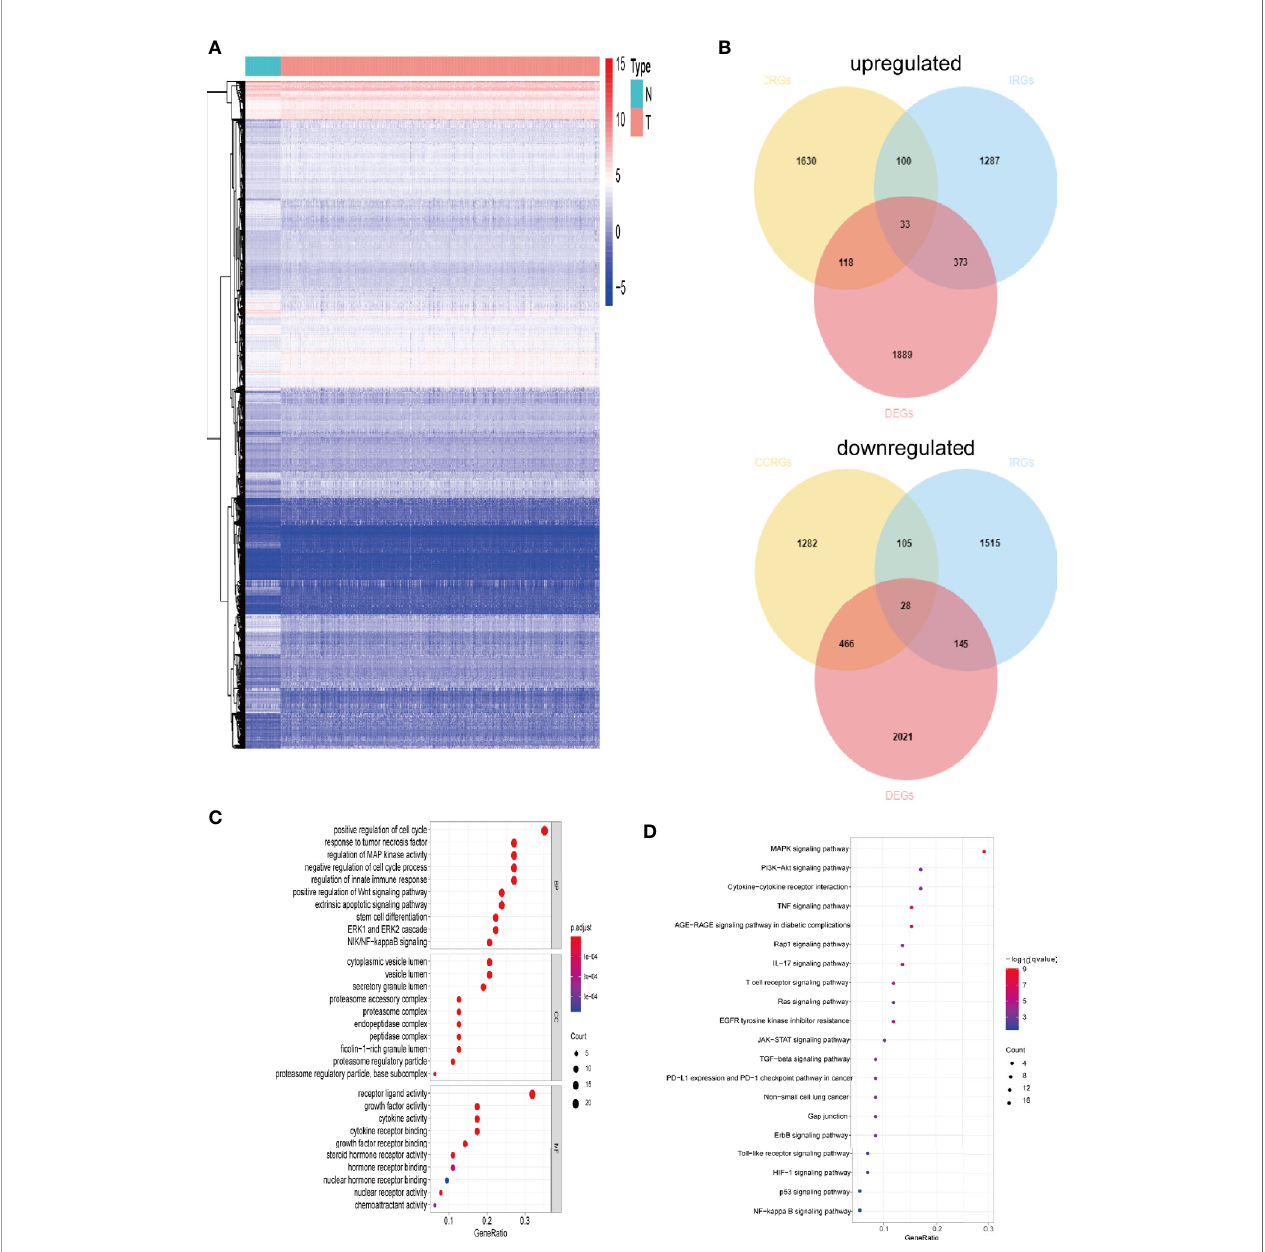
FIGURE 1 | Comparison of gene expression pro fi le with CCRGs and IRGs of LUAD. (A) Heatmap of differentially expressed genes in LUAD. (B) Venn diagram of up- and down-regulated differentially expressed genes based on CCRGs and IRGs. (C) GO analysis. (D) KEGG